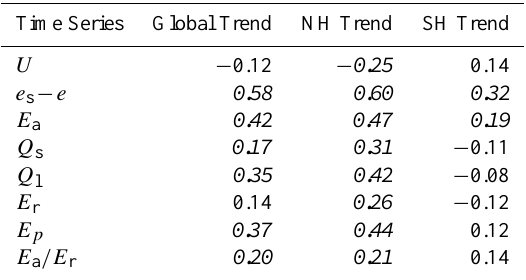
Table 1. Global, North Hemisphere (NH) and South Hemisphere (SH) normalised anomaly trends for potential evaporation over land areas and other relevant physical quantities, for the period July 1983–June 2008. The numbers are the slopes of Figs. 4–6 (except the E a /E r slope) in units of decade − 1 . Numbers in italics corre- spond to trend slopes significantly different from zero at the 95% confidence